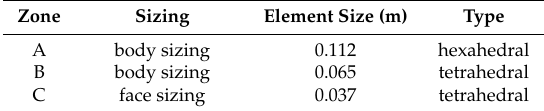
Table 2. Mesh properties in the multi-zone fluid domain.